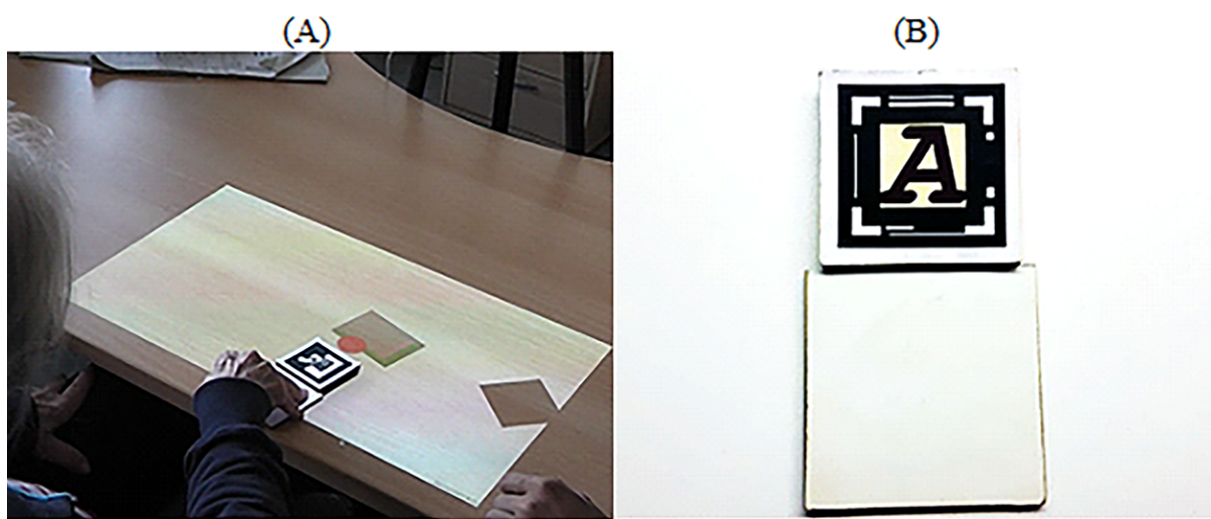
Figure 9. Dragging spheres. (A) Participants are collecting red spheres using a physical object. (B) Physical objects that participants use to interact with the